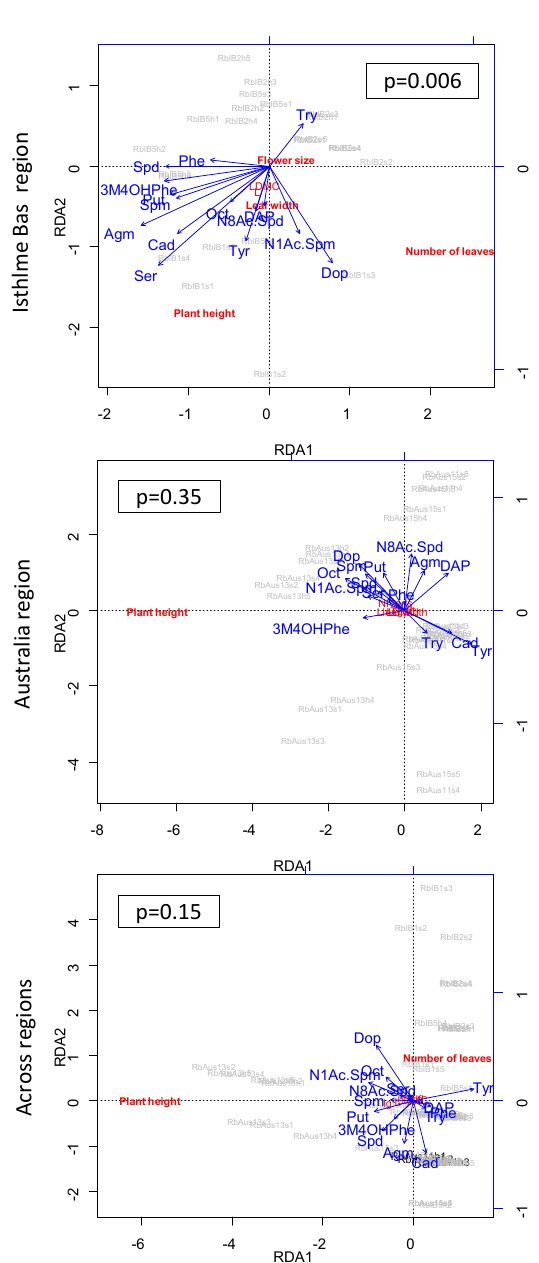
Figure 4. Full relationship between all amine compounds and all traits in R. biternatus within and across regions, from redundancy analysis. Traits are Plant height, Number of leaves, Flower size, Leaf length, Leaf width, LDMC (Leaf Dry Matter Content). In redundancy analyses, axes are constrained to show, at best, variance explained by amines. Individual traits (in bold) and amines (with arrows) are indicated. N = are 28 in Isthme Bas; 30 in Australia; 58 across regions. p values ( p ) are indicated.